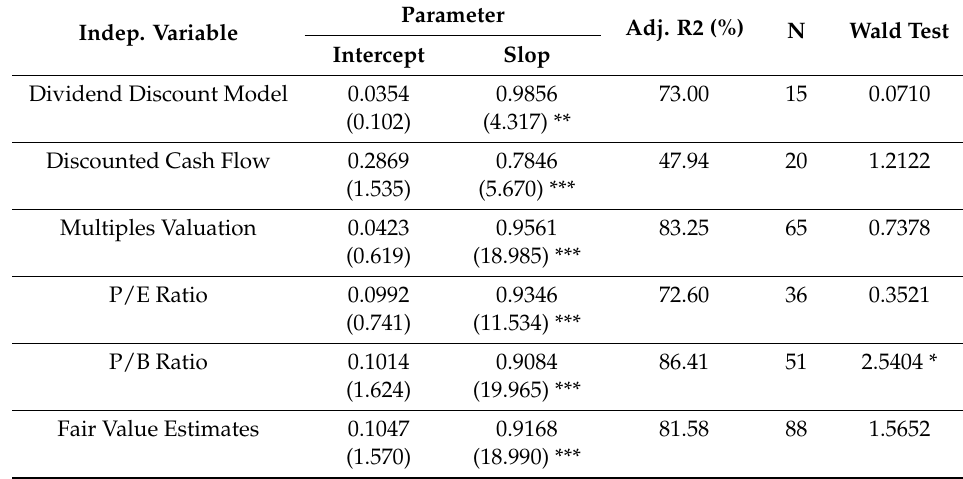
Table 7. The Analysis of Value Relevancy through Regressions.